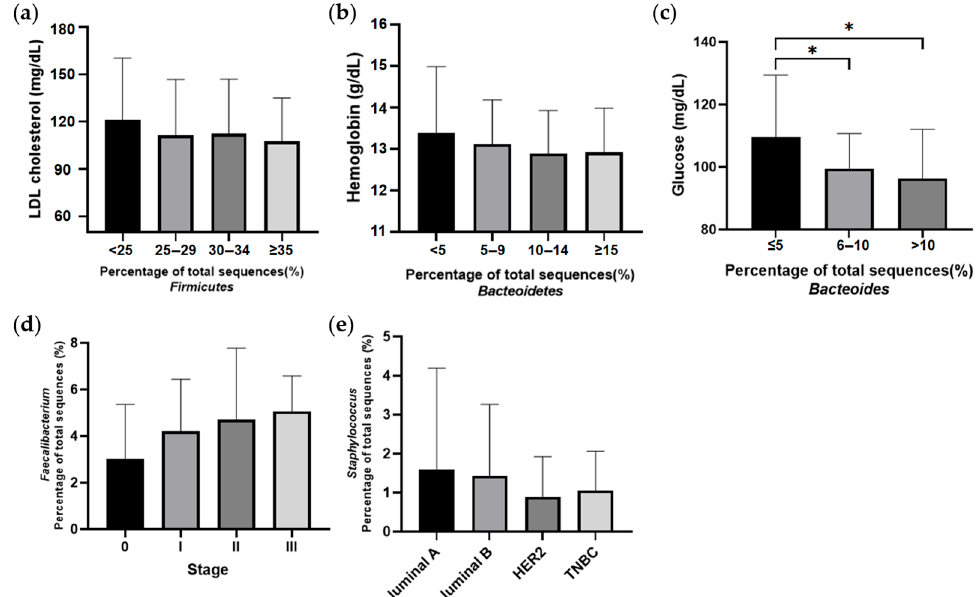
Figure 5. Relationships of specific microbiome member abundance to factors related to breast cancer. ( a ) LDL cholesterol levels (mg/dL) according to abundance of phylum Firmicutes. ( b ) Hemoglobin levels (g/dL) according to abundance of phylum Bacteroidetes. ( c ) Fasting serum glucose levels (mg/dL) according to abundance of genus Bacteroides . ( d ) Abundance of genus Faecalibacterium according to stage of breast cancer. ( e ) Abundance of genus Staphylococcus according to subtypes of breast cancer (luminal A, luminal B, human epidermal growth factor receptor 2 (HER2), or triple negative breast cancer (TNBC)). * p < 0.05.